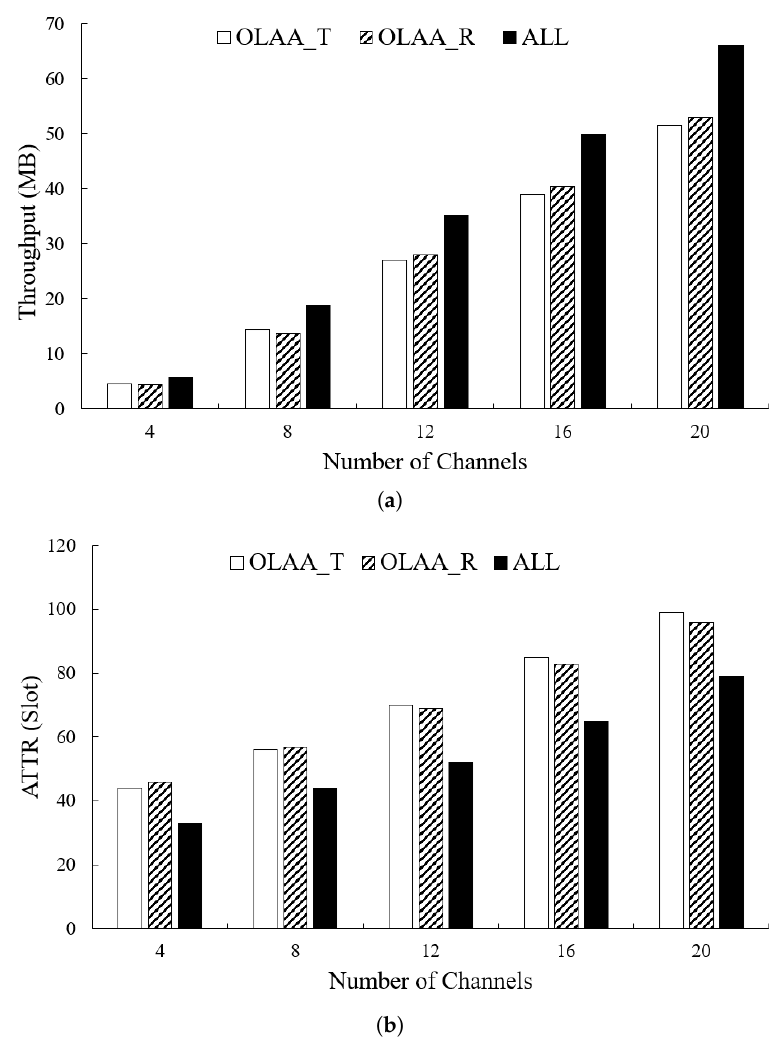
Figure 7. This figure displays the impact of the number of channels on the star topology’s performance in a synchronous network, as measured by two metrics: ( a ) throughput and ( b )